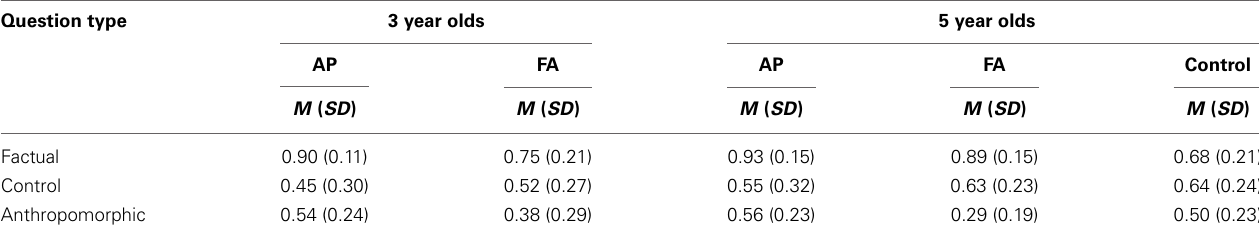
Table 2 | Mean proportion of correct responses for children in the Anthropomorphic Pictures (AP), Full Anthropomorphism (FA), and No Book control condition in Study